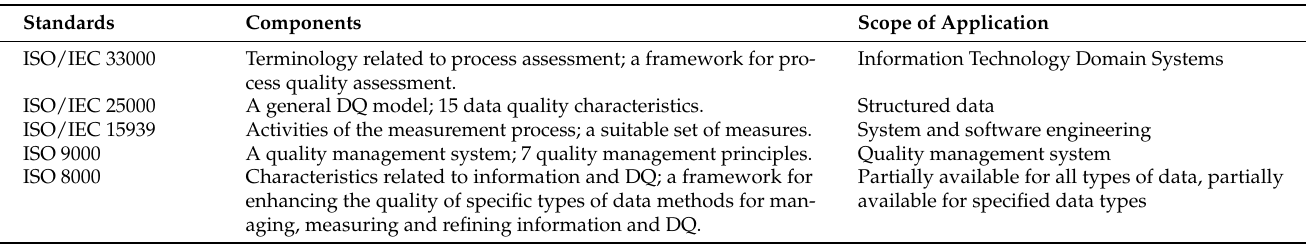
Table 3. ISO standards related to data